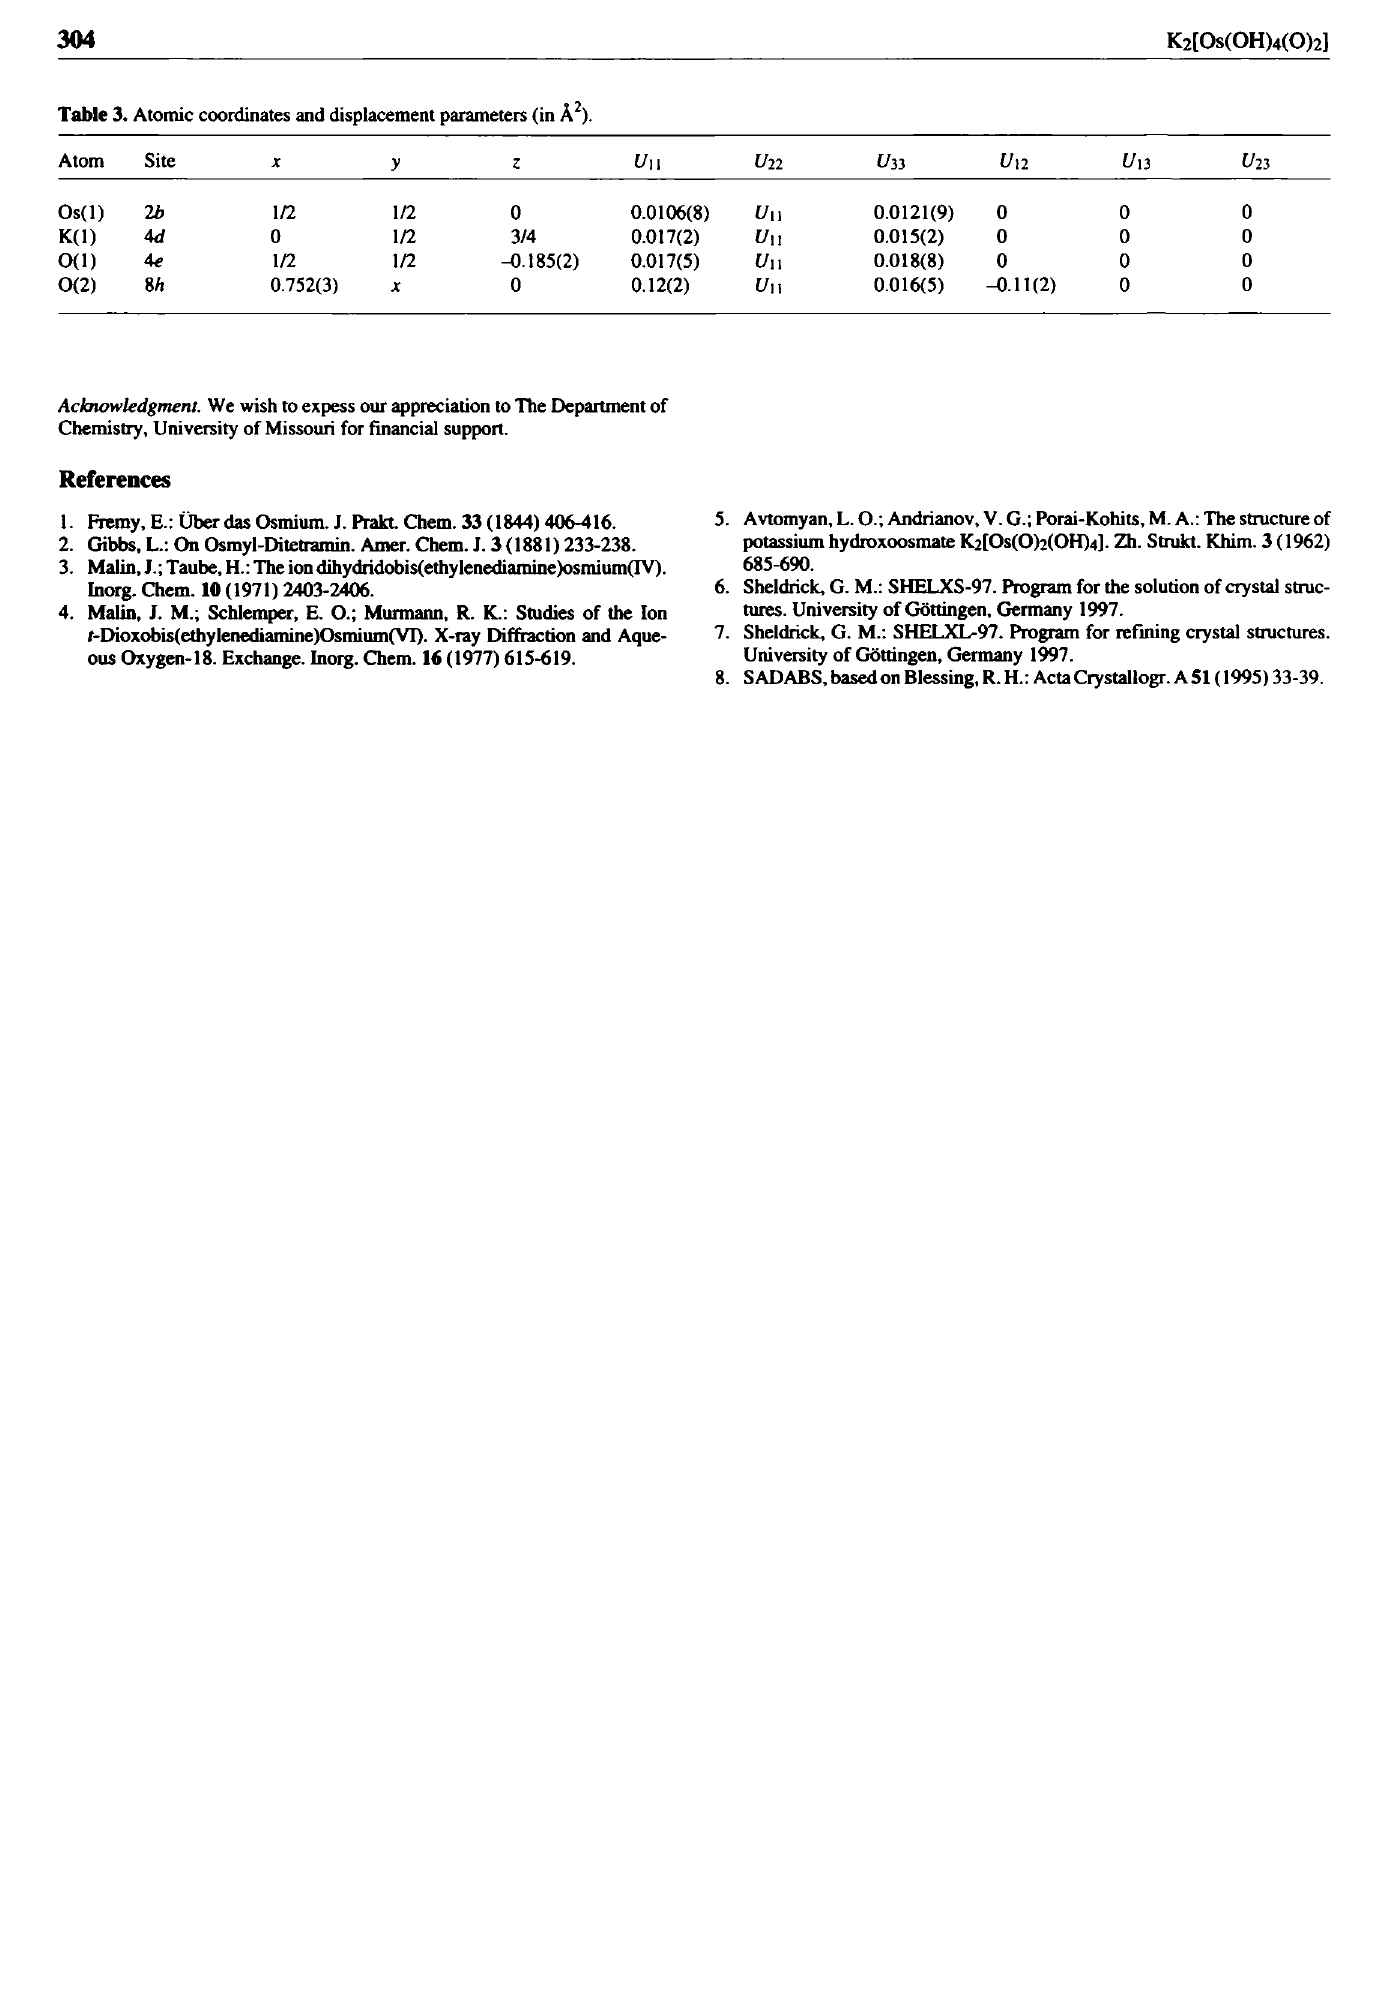
Table 3. Atomic coordinates and displacement parameters (in Â 2